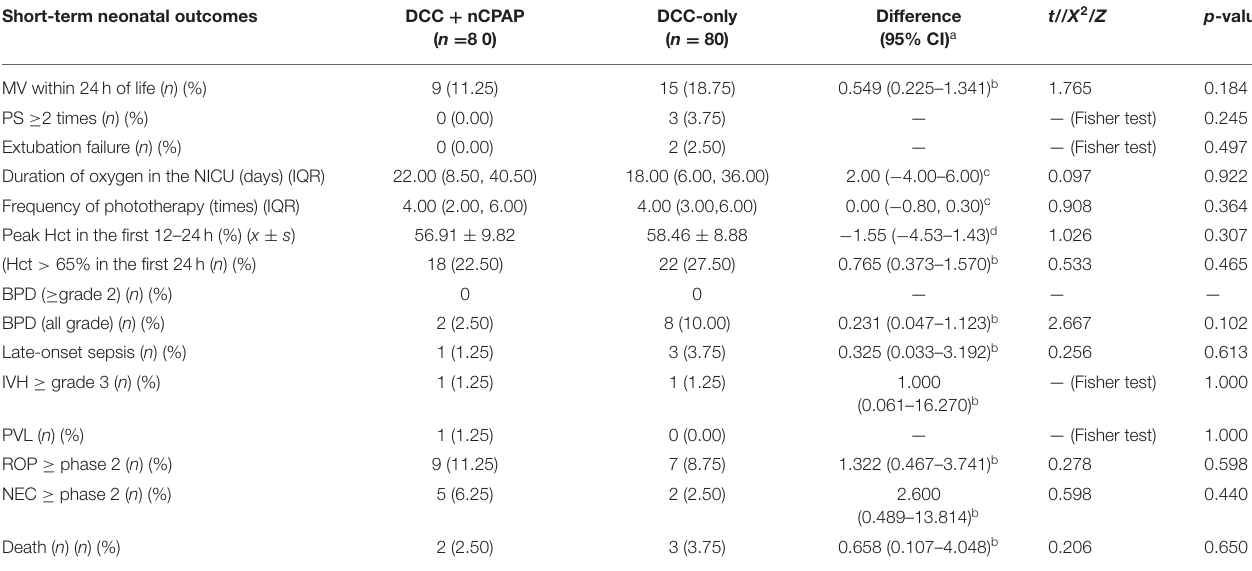
TABLE 3 | Short-term neonatal